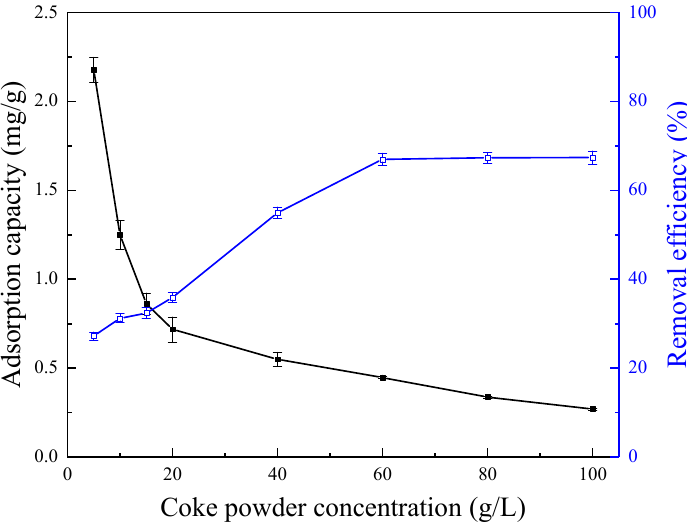
Figure 5. The e ff ect of coke powder concentration on pyridine removal e ffi ciency and adsorption Figure 5. The effect of coke powder concentration on pyridine removal efficiency and adsorption capacity of capacity of pyridine.